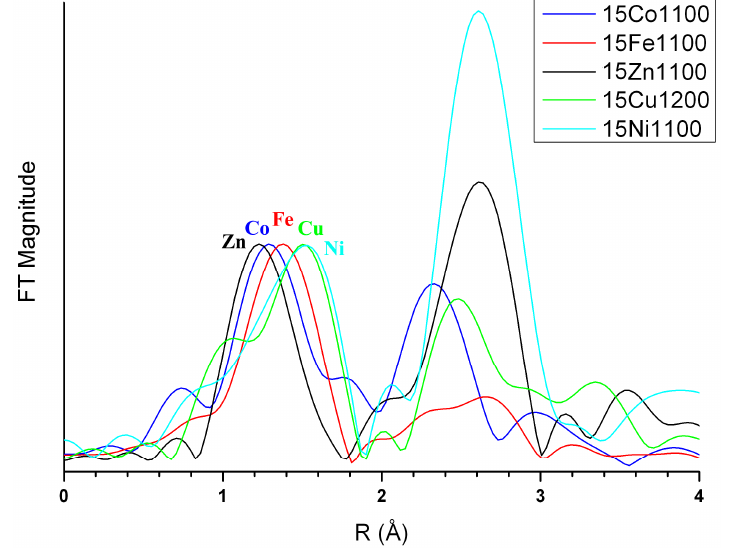
Figure 11. k 3 -weighted amplitude of the Fourier transform, uncorrected for phase shift, for 15Zn-1100 (black line), 15Cu-1200 (green line), 15Ni-1100 (light blue line), 15Co-1100 (blue line), and 15Fe-1100 (red line).